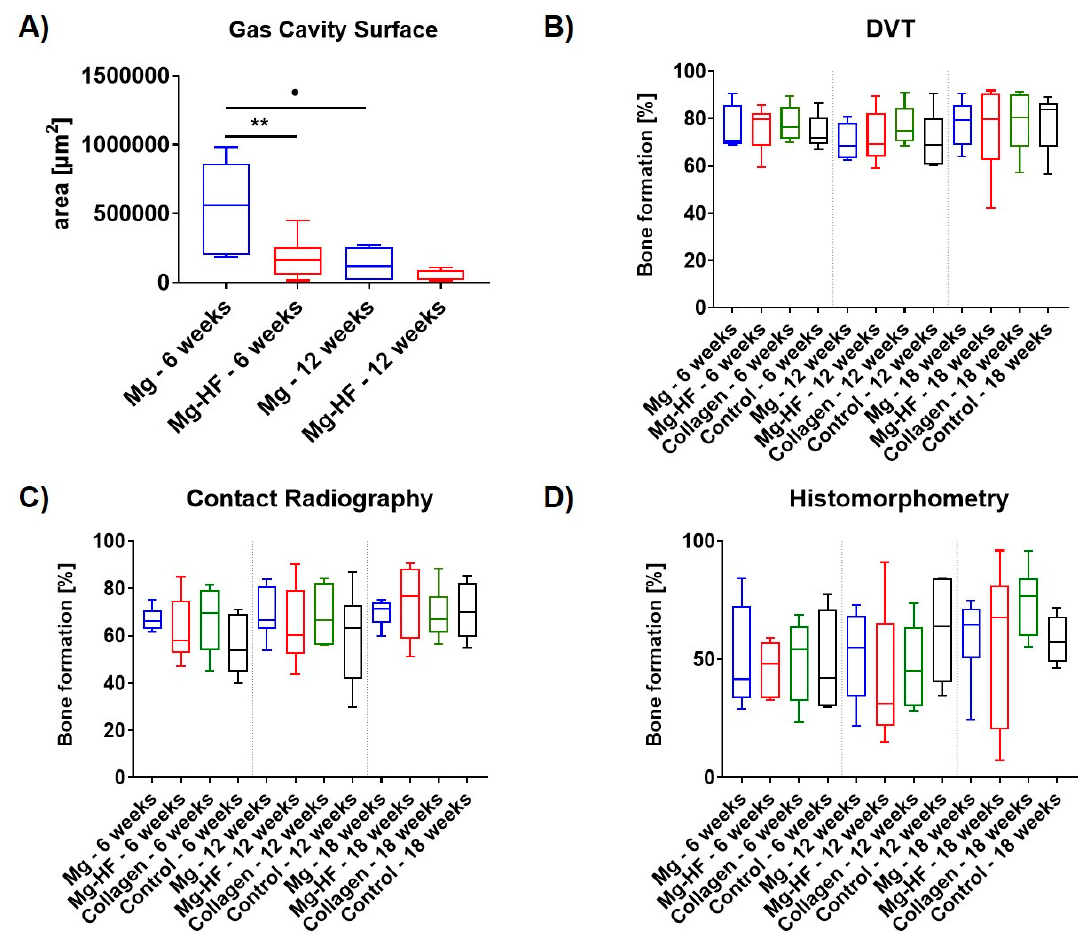
Figure 8. Overview of the various quantitative measurements. ( A ) Gas cavity surface in µ m 2 for uncoated (Mg; blue) and HF-treated (Mg-HF; red) magnesium after 6 and 12 weeks. HF-treated magnesium meshes show significantly lower gas cavity development compared to untreated magnesium meshes (**: p < 0.01) up to 6 weeks after implantation. Gas cavity dimension of untreated magnesium meshes shows to be reduced significantly after 12 weeks ( • : p < 0.05). ( B – D ) Bone regeneration as measured with contact radiography, DVT and in histomorphometry after 6, 12 and 18 weeks for uncoated (Mg; blue) and HF-coated magnesium (Mg-HF; red), collagen (Collagen; green) and control (Control; black). No significant differences ( p > 0.05) were detectable.